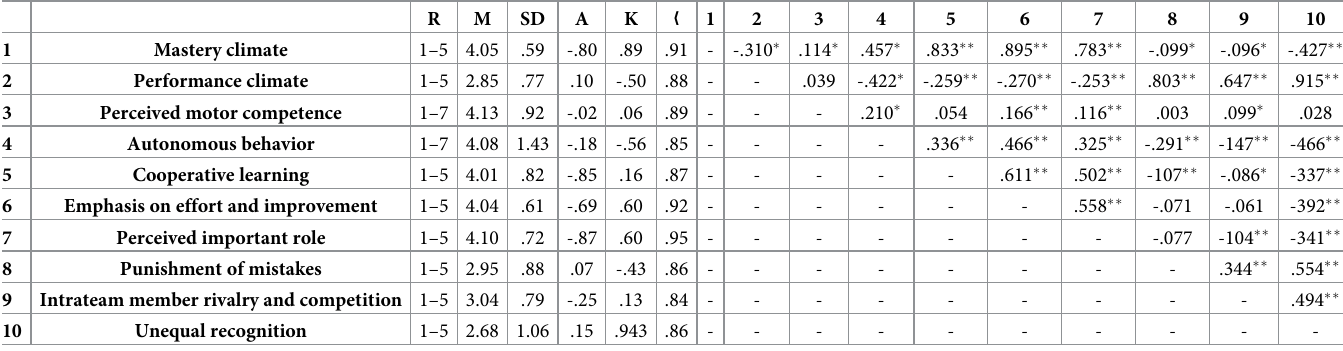
Table 2. Descriptive analysis and correlations.